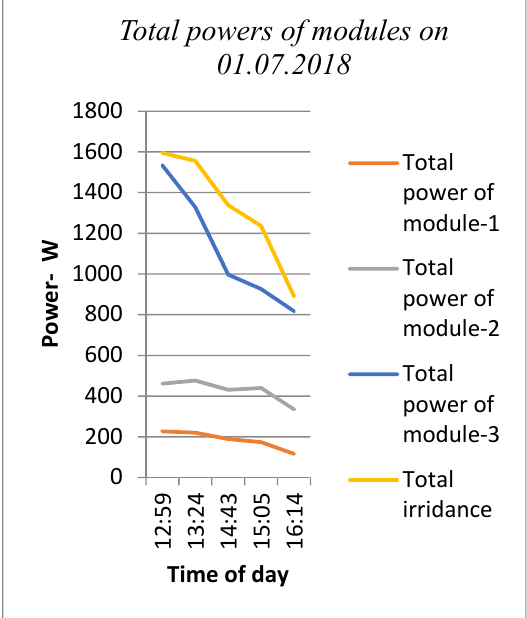
Figure 17. Total powers of moduleson 01.07.2018.